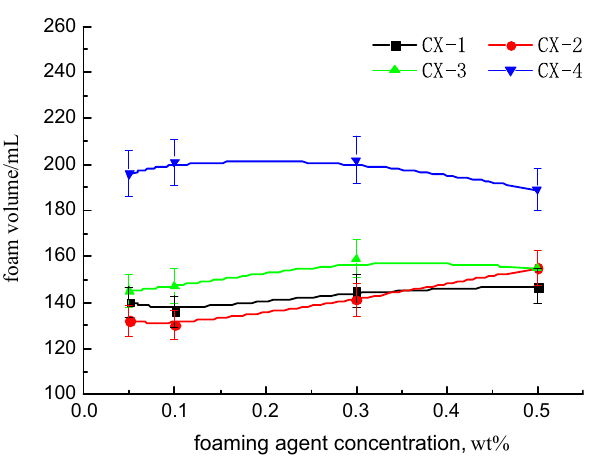
Figure 1: Foaming volume of the foaming agent at 300°C.